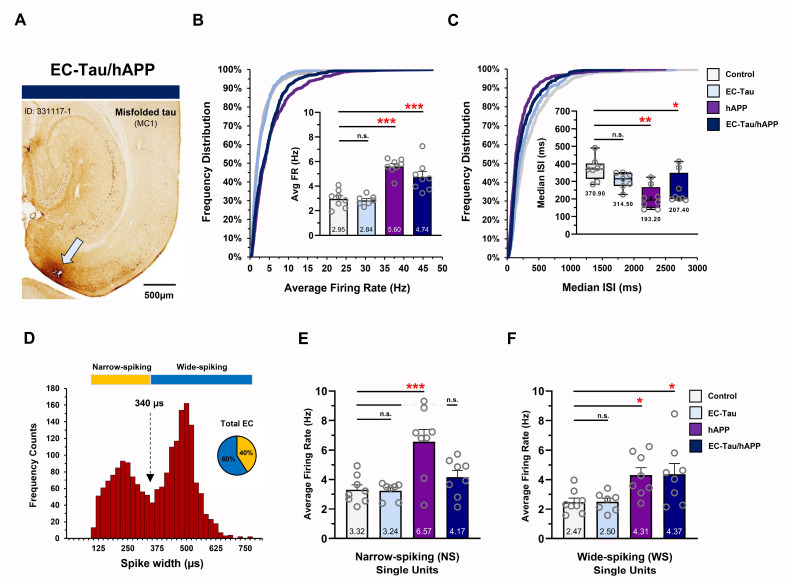
Aβ-associated hyperactivity in EC single units in vivo.In vivo multielectrode recordings were performed in the EC of 16-month EC-Tau/hAPP mice (n = 8) and their age-matched littermates: EC-Tau (n = 7), hAPP (n = 8), and nontransgenic control mice (n = 8). A. MC1+ horizontal brain section from an EC-Tau/hAPP mouse depicting tetrode tract mark (arrow). Scale bar, 500 μm. B. Cumulative frequency distributions of the neuronal average firing rates for all single units collected. Neurons from EC-Tau/hAPP and hAPP mice exhibit distribution shifts toward higher firing rates versus control. Two-sample Kolmogorov–Smirnov test: EC-Tau/hAPP versus control: D = 0.263, p < 0.001; hAPP versus control: D = 0.281, p < 0.001. Insert, average firing rates for EC-Tau/hAPP and hAPP mice were nearly 2-fold higher than Control. One-way ANOVA: p < 0.001. C. Cumulative frequency distributions of EC neuron median ISIs show shifts in the distributions of both EC-Tau/hAPP and hAPP mice versus control. Two-sample Kolmogorov–Smirnov test: EC-Tau/hAPP versus control: D = 0.217, p < 0.001; hAPP versus control: D = 0.284, p < 0.001. Insert, box-and-whisker plots depicting median and mean (+) ISI values per genotype. Median ISI values were significantly decreased in EC-Tau/hAPP and hAPP mice compared with control. Kruskal–Wallis test: p < 0.01. D. Neuronal firing rates were binned and plotted as a function of waveform spike width. The resulting frequency histogram showed a bimodal distribution. A cutoff of 340-μm spike width was used to delineate putative interneurons (NS cells; yellow) from putative excitatory neurons (WS, cells; blue) (broken arrow). E. hAPP mice exhibit increased NS cell firing rates versus control. One-way ANOVA: p < 0.01. F. EC-Tau/hAPP and hAPP mice exhibit increased WS cell firing rates versus Control. One-way ANOVA: p < 0.001. Bar graphs represent mean ± SEM. Box-and-whisker plots represent median with minimum thru maximum values shown. Individual values per mouse appear as overlays. For Animal ID and sex of individual mice, please see S1 Data. *p < 0.05; **p < 0.01; ***p < 0.001. Source data are available in S1 Data. Aβ, amyloid-beta; DG, dentate gyrus; EC, entorhinal cortex; hAPP, human amyloid precursor protein; HIPP, hippocampus; ID, identification; ISI, interspike interval; MC1, antibody for misfolded tau; NS, narrow-spiking; SEM, standard error mean; WS, wide-spiking.